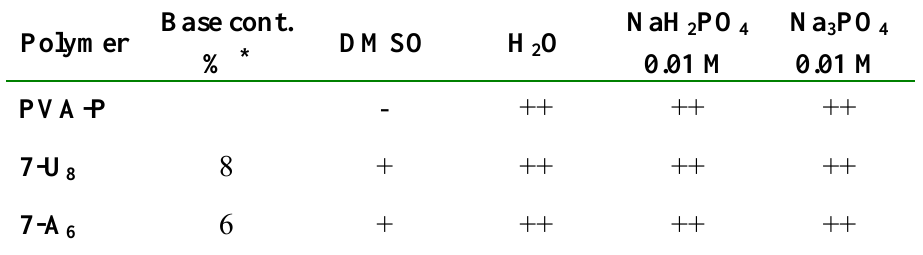
Table 2. Solubility of nucleic base analogs containing polyvinyl alcohol phosphate